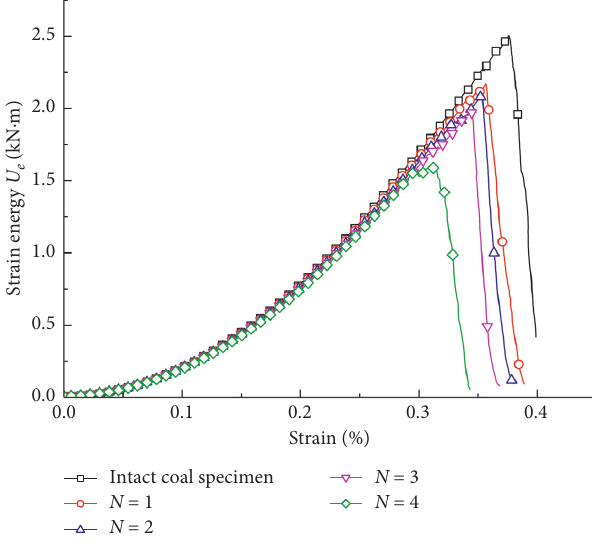
Figure 19: Curve of dissipated energy and strain.